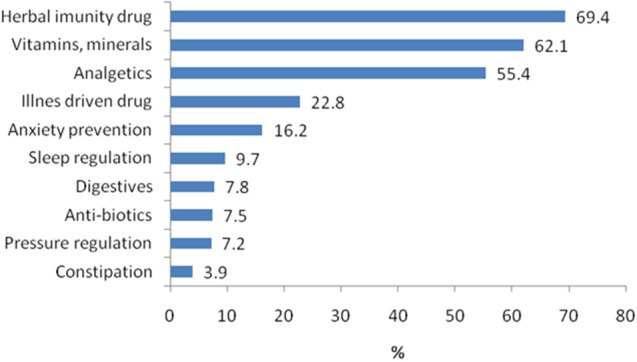
Most commonly consumed drugs, herbal preparations, and vitamins selected by personal choice.